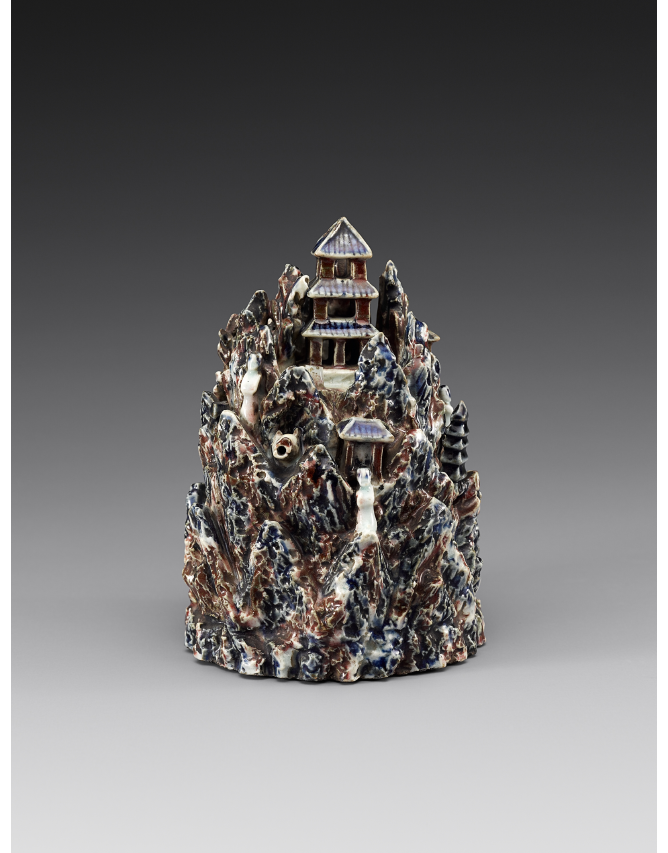
Figure 9. Paksan ‑shaped Water Dropper, 19th century, Chosŏn dynasty (1392–1910). Porcelain with cobalt-blue and copper-red painting in underglaze. H 19.0 cm. National Museum of Korea (pon 8143). Photograph licensed under Creative Commons, reproduced with permission from National Museum of Korea, Seoul.